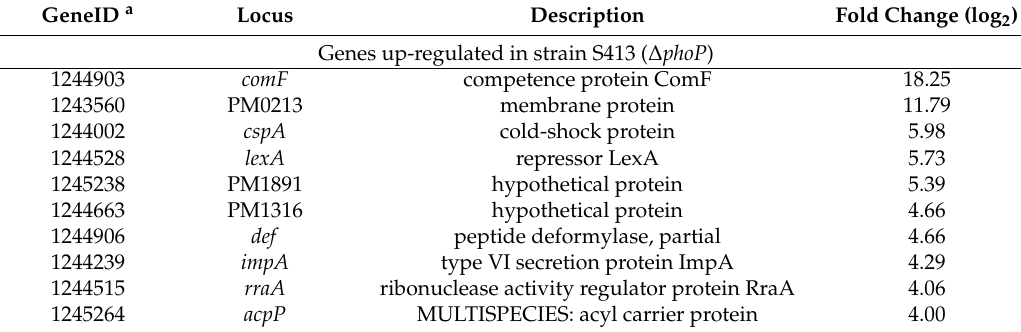
Table 2. Partial list of differentially expressed genes between the parent strain and the ∆ phoP mutant. GeneID a Locus